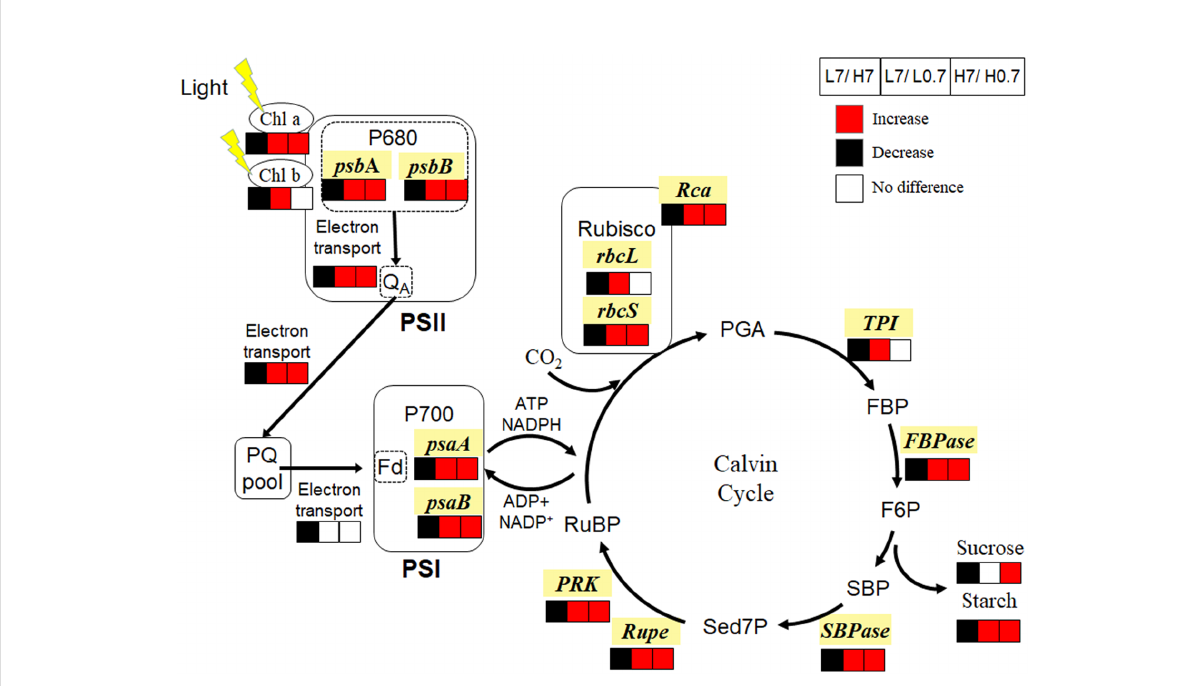
FIGURE 7 Effect of R/FR on photosynthetic electron transport and Calvin cycle in cucumber leaves under salt stress. Compared to L7 treatment, H7 treatment signi fi cantly decreased chlorophyll a , chlorophyll b , sucrose and starch contents, inhibited electron transport from PSII to PSI, and down-regulated expressions of genes (e.g., psbA , psbB , psaA , psaB , rbcL , rbcS , Rca , TPI , FBPase , SBPase , Rupe and PRK ) involved in photosynthesis; While L0.7 treatment signi fi cantly increased chlorophyll a , chlorophyll b and starch contents, improved electron transport from PSII to PQ pool, and up-regulated expressions of genes (e.g., psbA , psbB , psaA , psaB , rbcL , rbcS , Rca , TPI , FBPase , SBPase , Rupe and PRK ) involved in photosynthesis. Compared to H7 treatment, H0.7 treatment signi fi cantly enhanced chlorophyll a , sucrose and starch contents, promoted electron transport from PSII to PQ pool, and up-regulated expressions of genes (e.g., psbA , psbB , psaA , psaB , rbcS , Rca , FBPase , SBPase , Rupe and PRK ) involved in photosynthesis. The red and black units represent enhancement and inhibition of photosynthesis apparatus or gene expression level, respectively, while white units represent no difference. Chl, chlorophyll; PSII, Photosystem II; P680, primary electron donor of PSII; Q A , primary electron acceptor quinone molecule; PSI, Photosystem I; P700, primary electron donor of PSI; PQ pool, plastoquinone pool; Rubisco, Ribulose-1,5-bisphosphate carboxylase-oxygenase; PGA, phosphoglycerate; FBP, fructose-1,6-bisphosphate; F6P, fructose-6-phosphate; SBP, Sedoheptulose-1, 7-bisphosphate; Sed7P, Sedoheptulose-7-bisphosphate; RuBP,